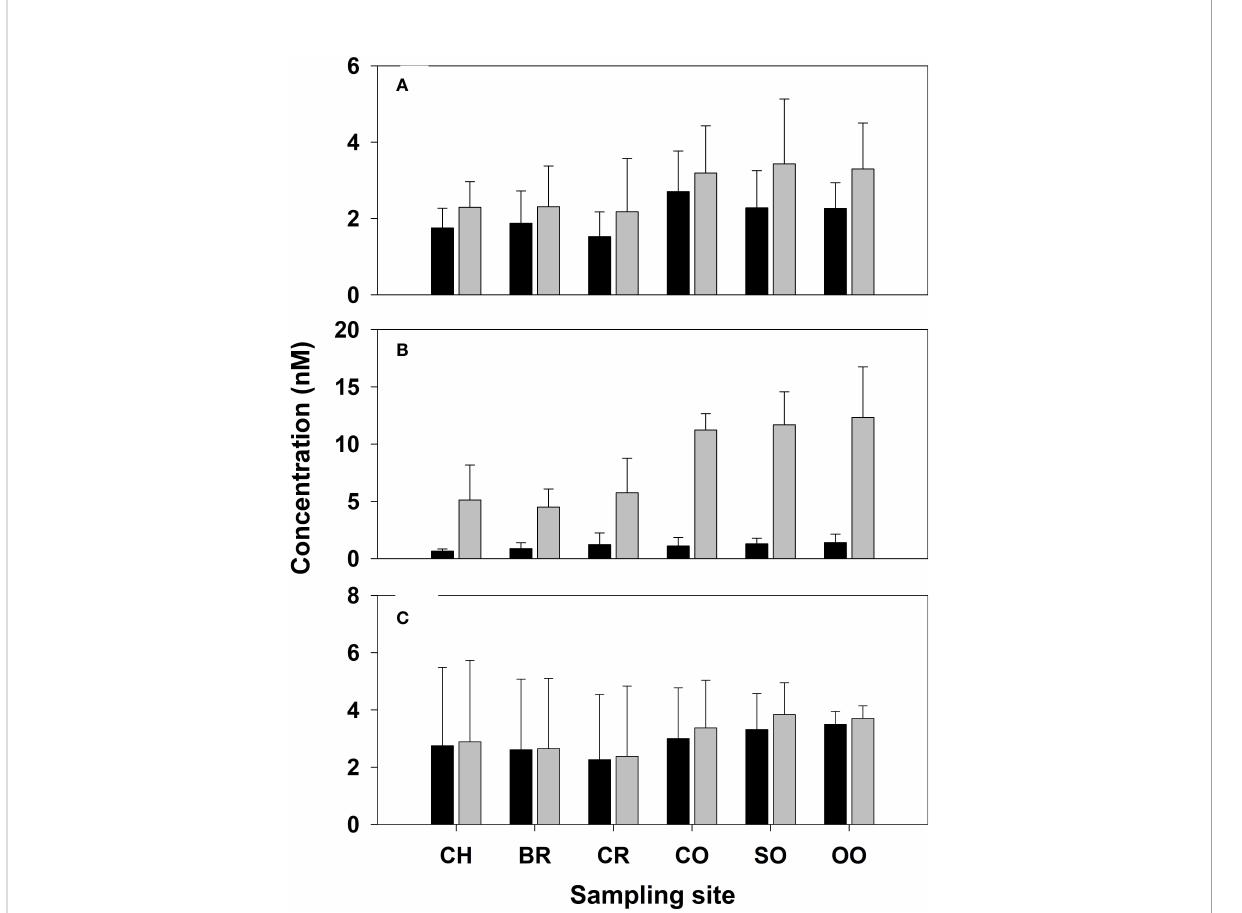
FIGURE 2 Mean dissolved (black- fi lled bars) and total (grey- fi lled bars) concentrations of (A) acrylate, (B) DMSP, and (C) DMSO in samples collected from repeated sampling at each sampling station between April 6 and 24, 2018. Error bars denote the standard deviation from the measurement of multiple samples collected over different days at each site (n = 4 –